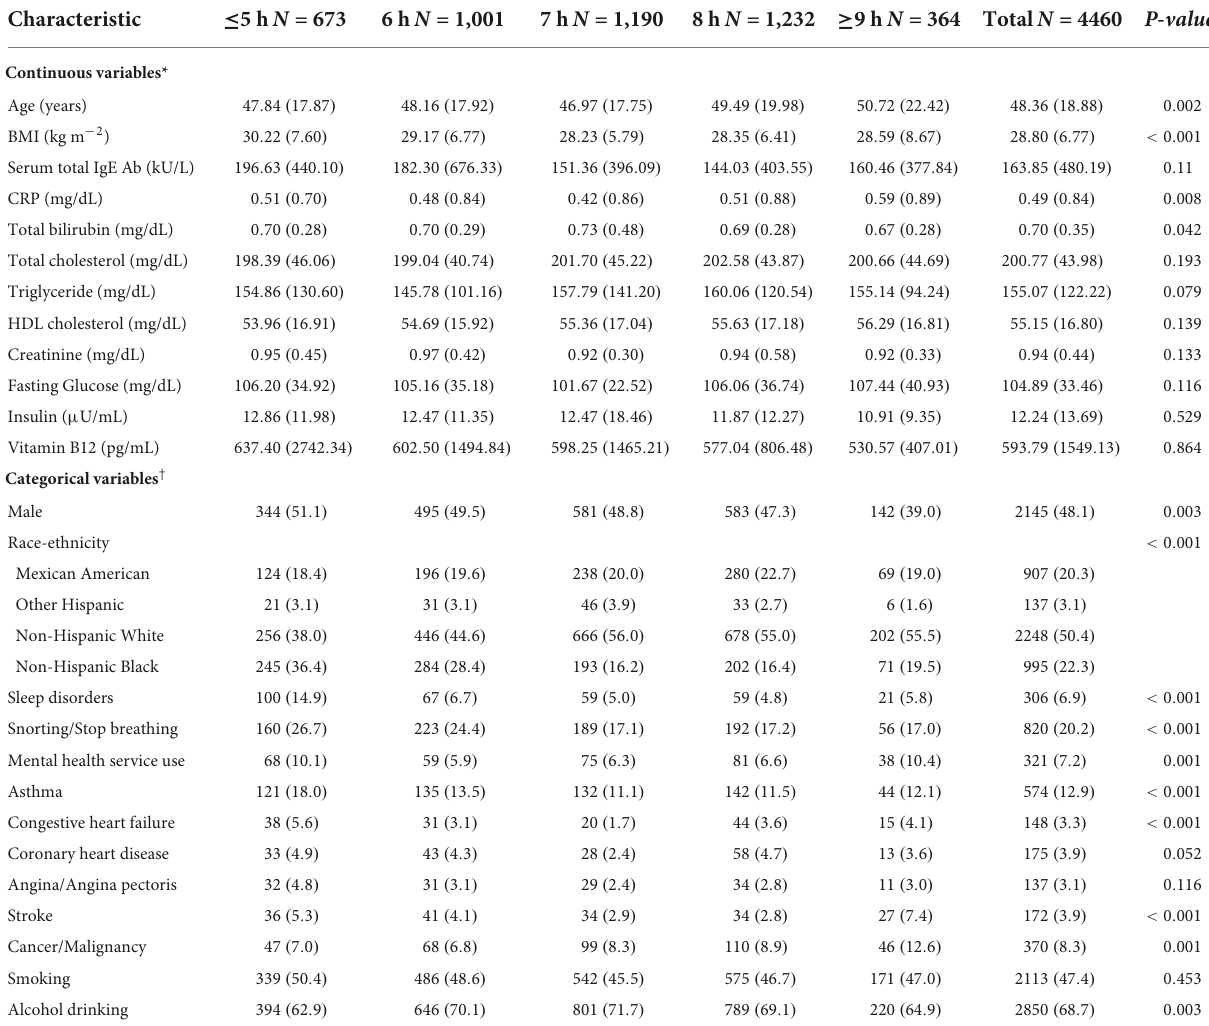
TABLE 1 Characteristics of study